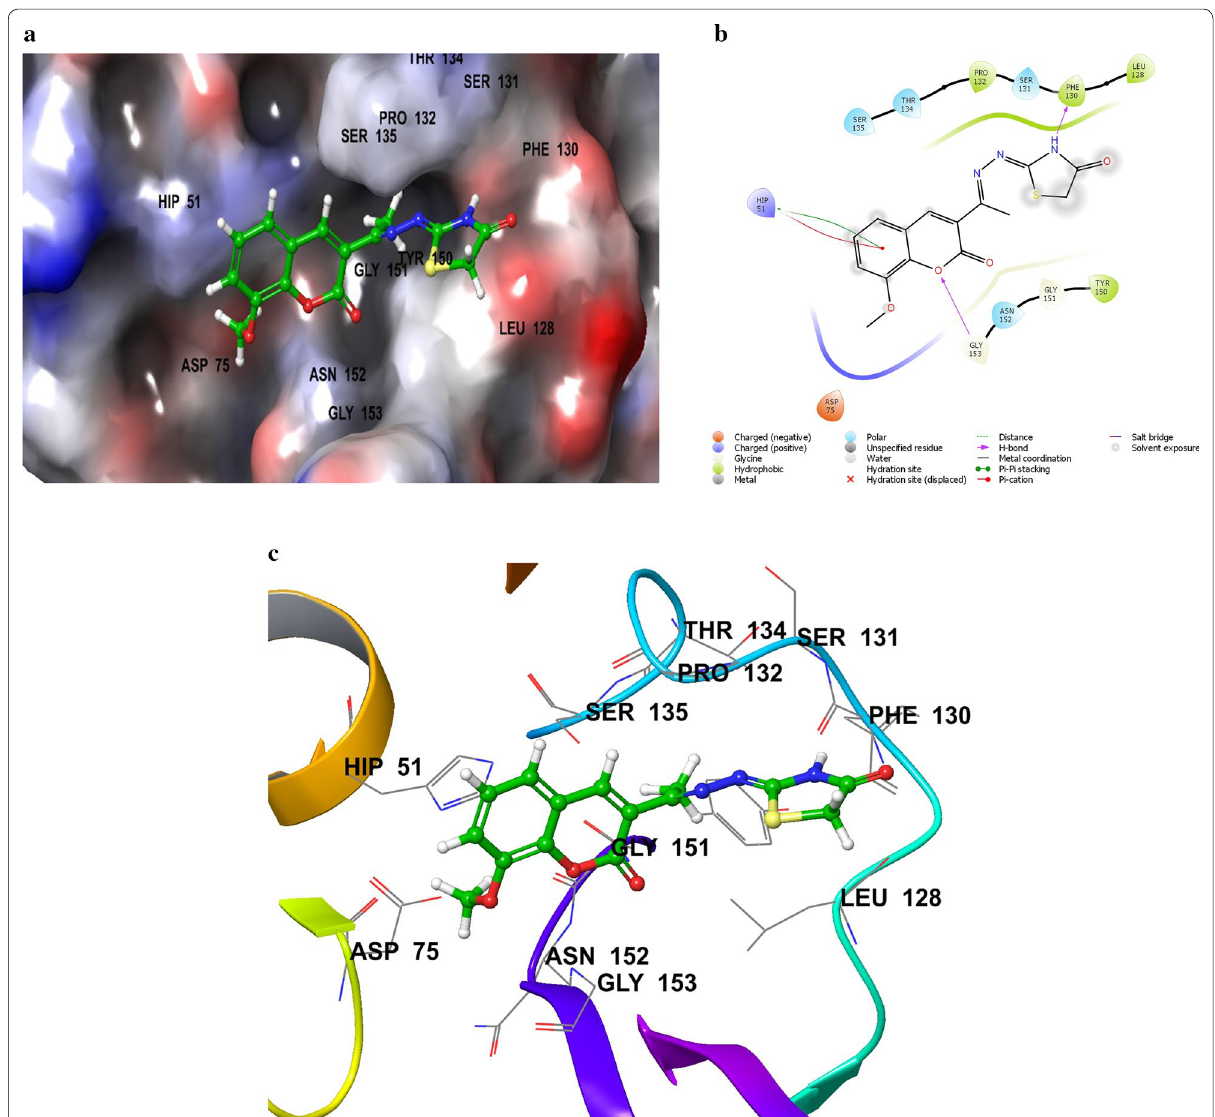
Fig. 6 Binding modes of compound SKYf with dengue virus NS2B/NS3 protease: a Protein as surface and compound as sticks; b Protein and compound as 2D interaction image; c Protein as ribbon and compound as